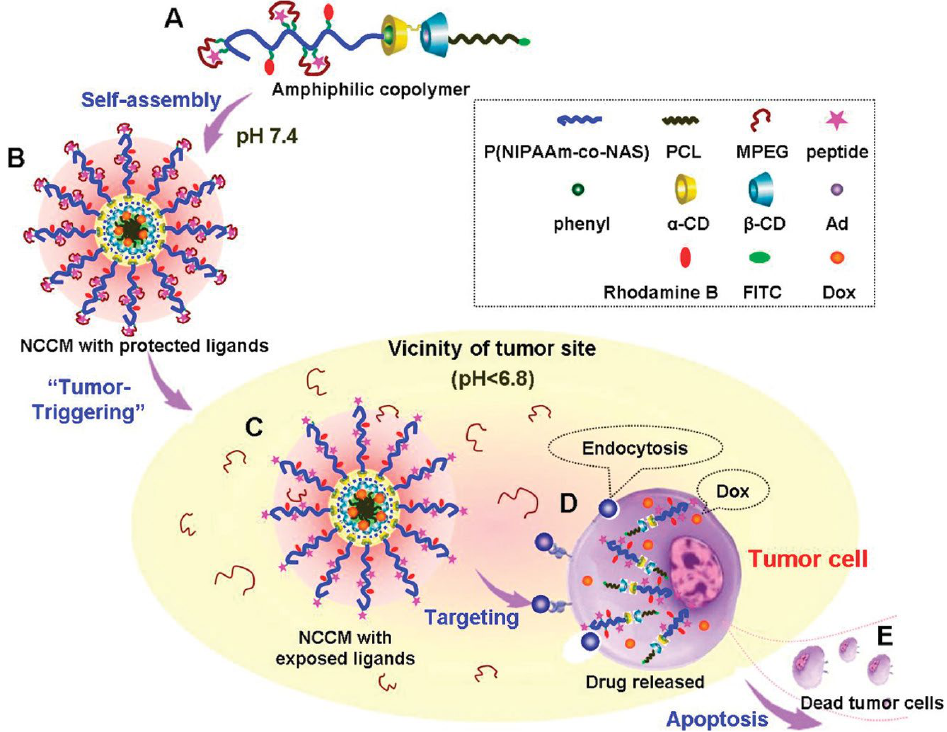
Figure 2. Schematic illustration of the formation of the NCCMs, DePEGylation for “tumor-triggered targeting”, and thermal-trigged drug release intracellular. Reprinted with permission from Ref. [58]; American Chemical Society. ( A ) Structure of the copolymer; ( B ) The formation of the NCCMs; ( C ) DePEGylation for “tumor-triggered targeting”; ( D ) Thermal-triggered drug release intracellular.